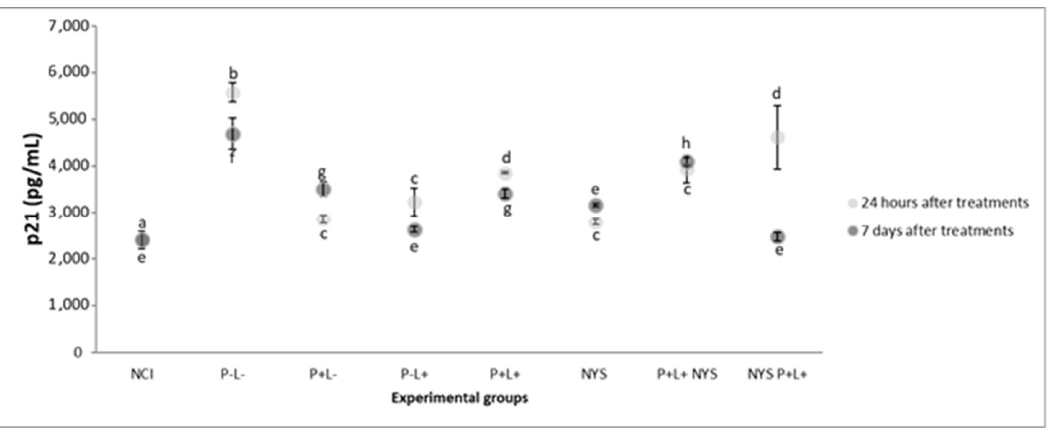
Figure 9. The mean values and standard deviation of the expression of p21 (pg / mL) for all the evaluated groups. The equal lowercase letters denote a statistical similarity among the experimental groups after 24 h and 7 days of treatment ( p > 0.05).